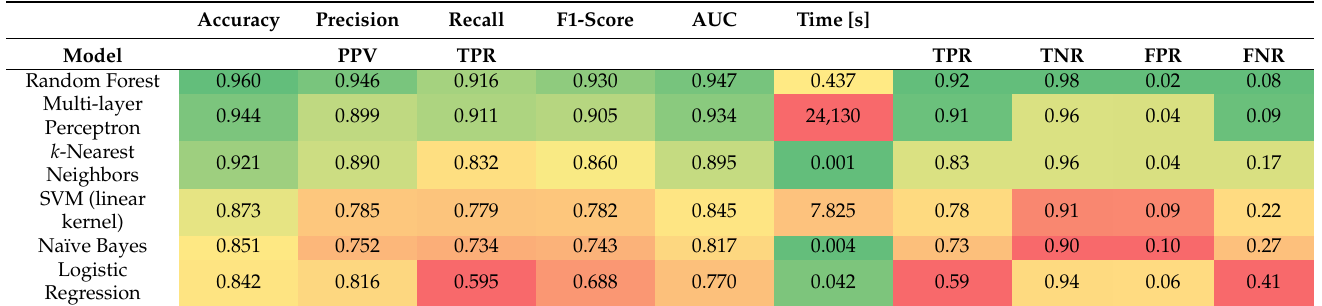
Table 2. Evaluation of machine learning algorithms: scalar performance measures and confusion matrix terms. Values are color-coded on a green (favorable values)-to-red (adverse values)